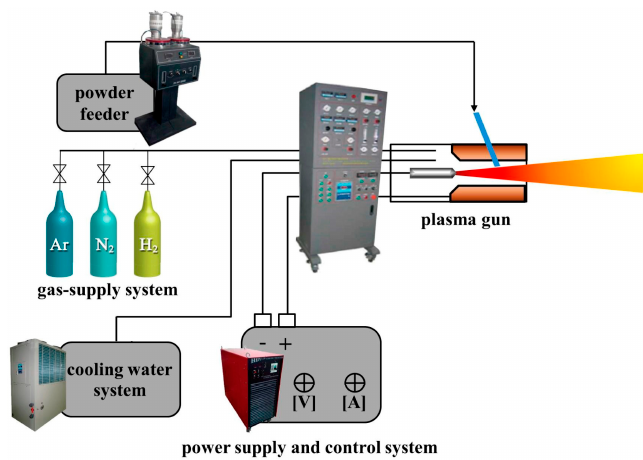
Figure 4. Schematic illustration of air plasma spray set-up. Reproduced from [106] with permission of MDPI under the terms and conditions of the Creative Commons Attribution license.